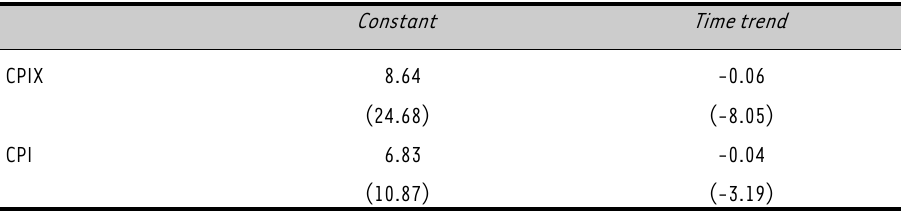
TABLE 6: Inflation trends,